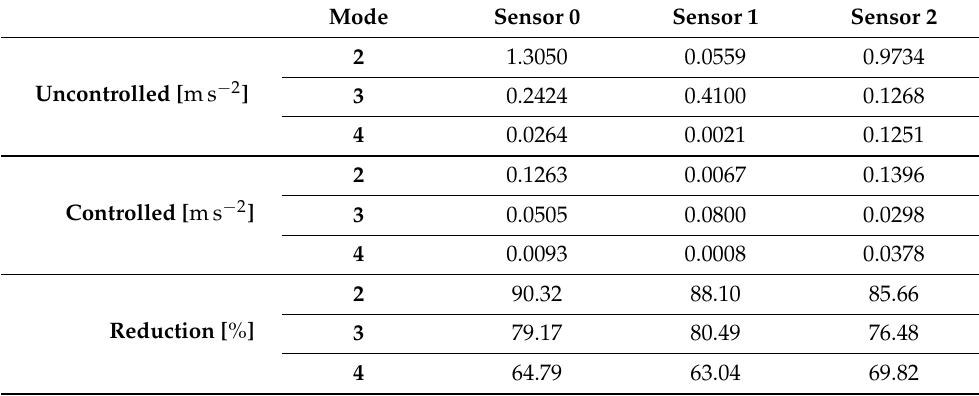
Table 3. Vibration comparison between uncontrolled and controlled case in numerical